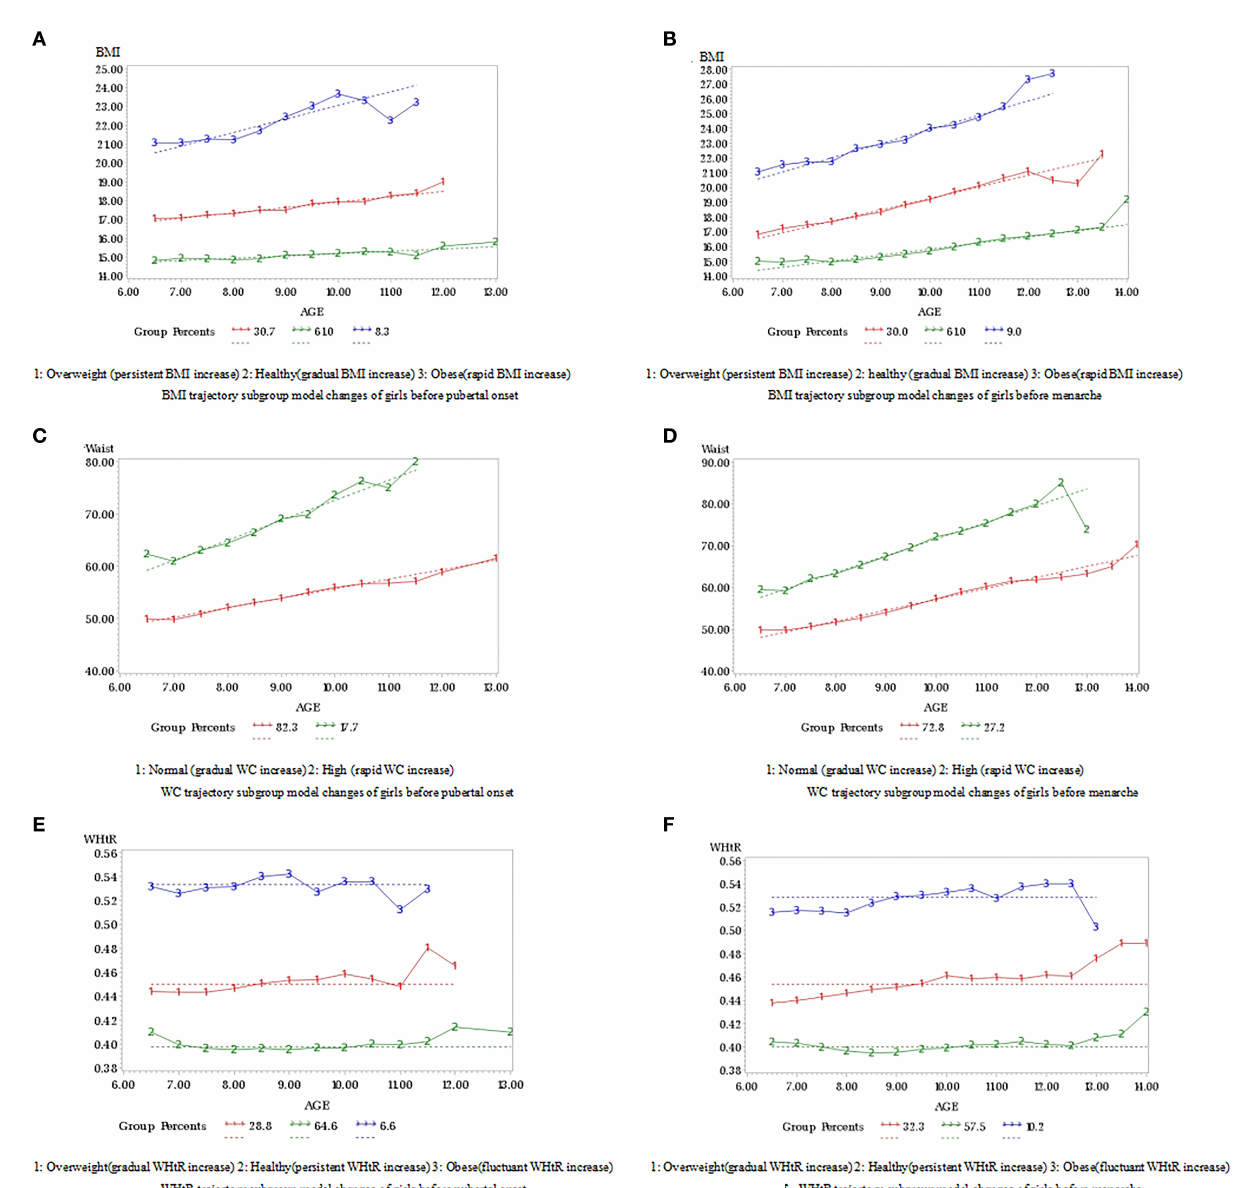
FIGURE2 (A–F) Trajectory changes of BMI, waist circumference and WHtR before pubertal onset and